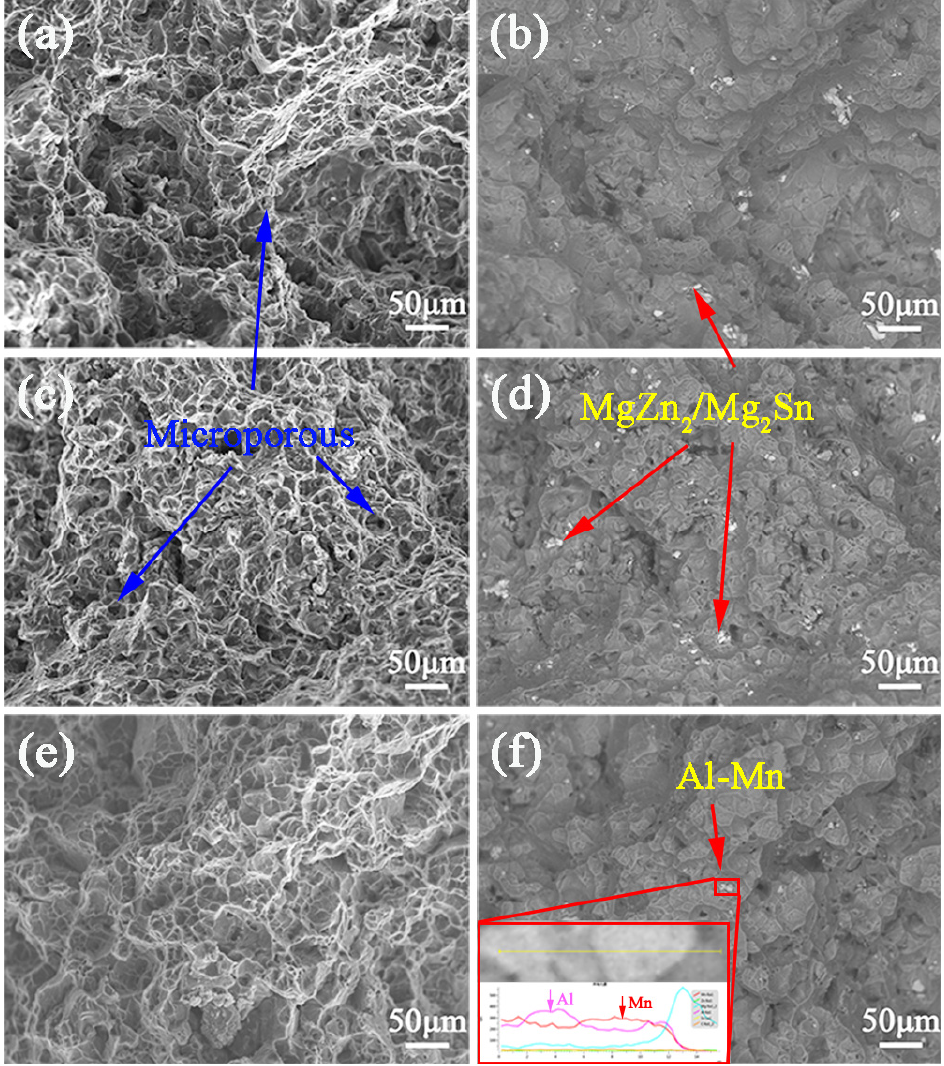
Figure 12. ( a , c , e ) SE-SEM, ( b , d , f ) and BSE-SEM micrographs of the fracture surface of double-aged ZTM641-xAl alloys tested at 200 °C, ( a , b ) x = 0, ( c , d ) x = 0.2 and ( e , f ) x = 2.